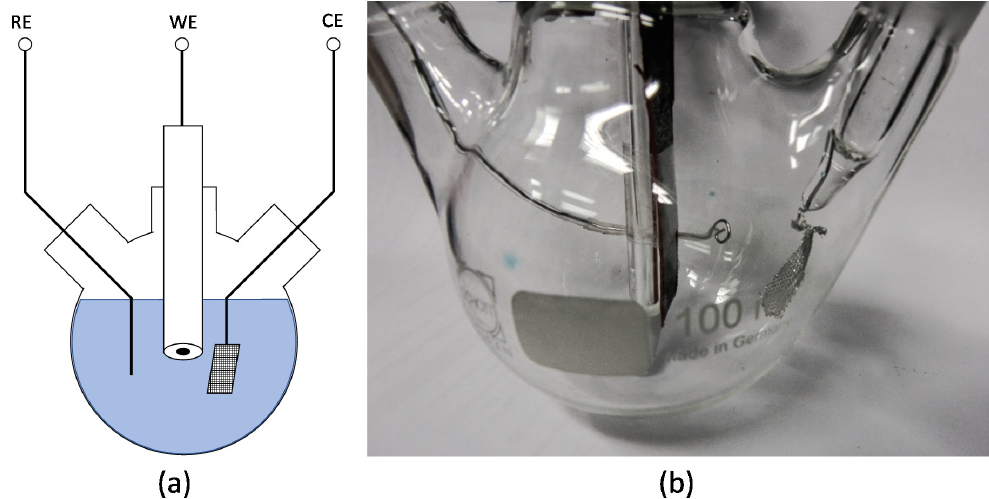
Figure 7. Experimental setup of rotating disc electrode (RDE) ( a ) and sensor ( b ) measurements, with RDE (diameter active area 5 mm) or sensor (active area 1 cm²) as working electrode (WE), platinum with RDE (diameter active area 5 mm) or sensor (active area 1 cm 2 ) as working electrode (WE), mesh (approx. 2 cm²) as counter electrode (CE) and platinum wire as reference electrode (RE), platinum mesh (approx. 2 cm 2 ) as counter electrode (CE) and platinum wire as reference electrode electrolyte volume during measurement 55 mL. (RE), electrolyte volume during measurement 55